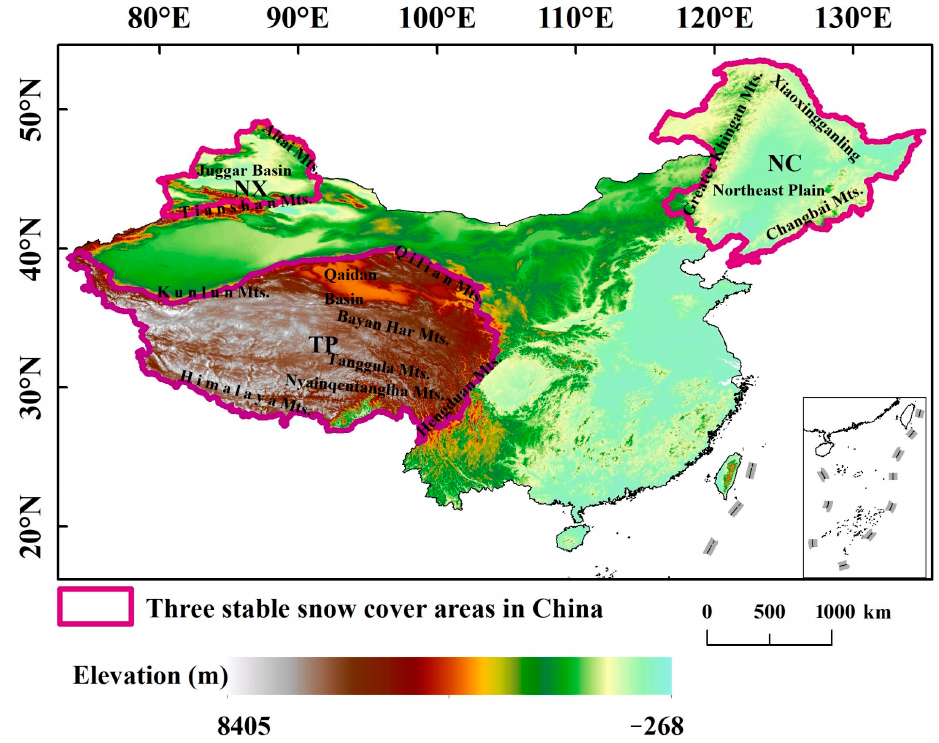
Figure 1. Digital elevation model of China and its distribution of three stable snow cover areas in China. The purple frames are the boundaries of the three stable snow cover areas in China. The abbreviations of the snow cover areas represent the Qinghai–Tibet Plateau (TP), North Xinjiang (NX), and Northeast China (NC). The illustration in the lower right corner is the South China Sea, and the dotted line represents the range line of the ownership line of Chinese islands.